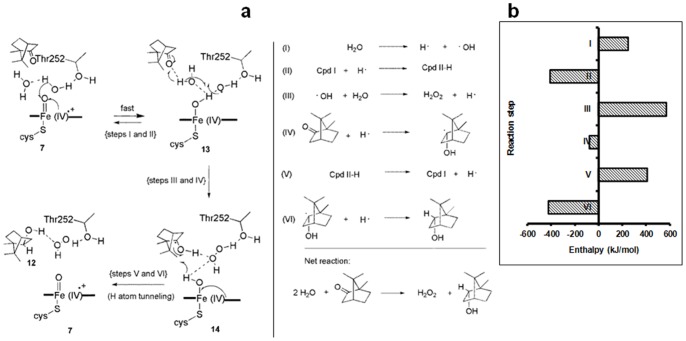
The proposed reduction mechanism and the Born-Haber estimates in the mechanism.
a) Proposed reduction mechanism of P450cam that accounts for the simultaneous formation of borneol 12 and H2O2, in a 1∶1 stoichiometry. b) Born-Haber cycle estimates of the reduction mechanism.